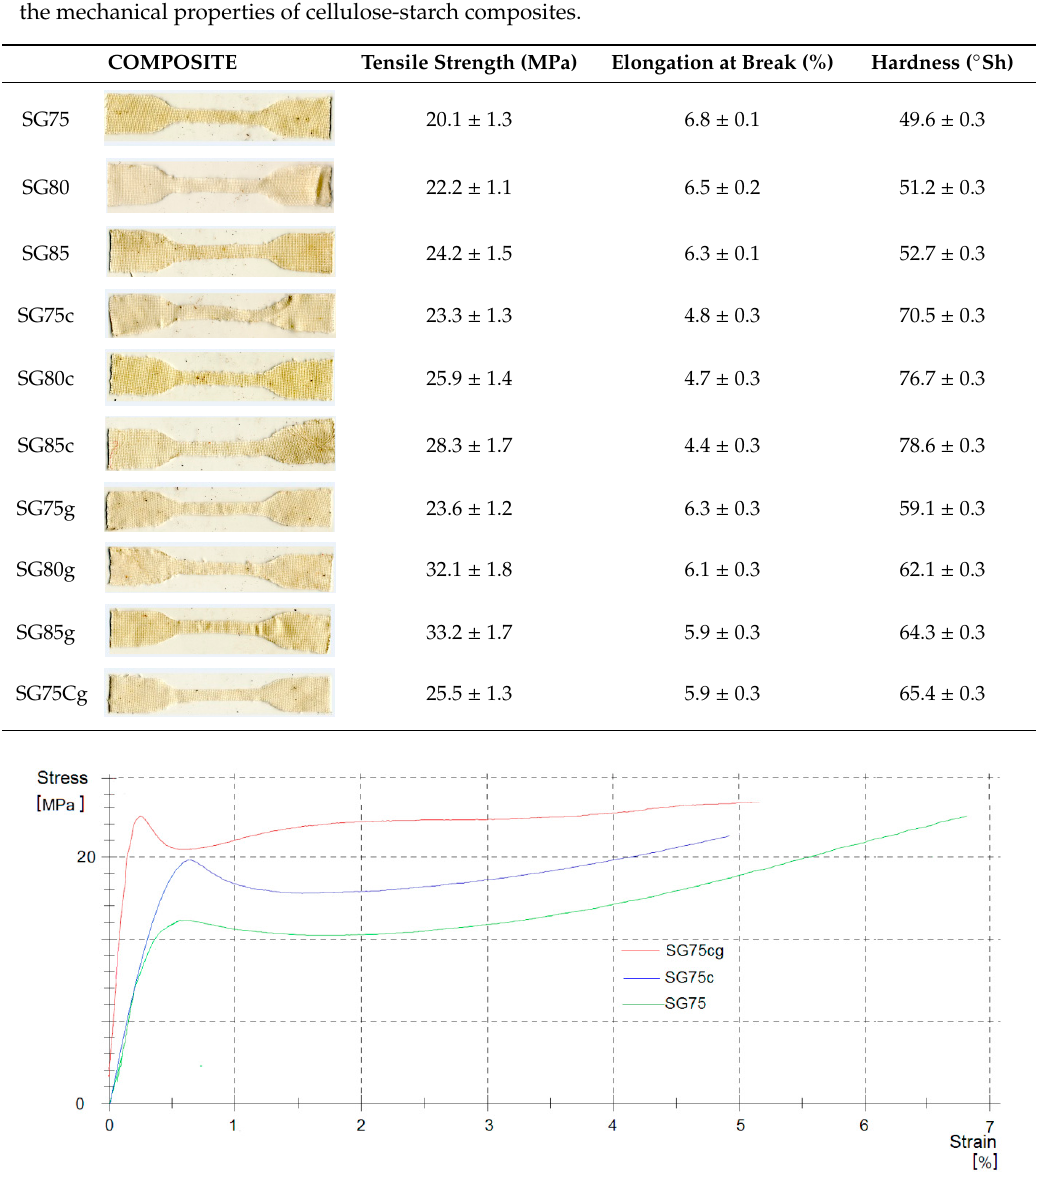
Figure 8. Representative strain curves from deformation (SG75, SG75c, SG75cg) in mechanical tests. As can be seen in Table 3, reducing the glycerin content improved the hardness of the composites considerably, while they also showed less flexibility. This is because glycerin acts as a plasticizer. Glycerin was added in different percentage shares, i.e., 25% (SG75), 20% (SG80) and 15% (SG85). The smaller the proportion of glycerin in the composites, the greater was their hardness in degrees Shore (°Sh) and the lower was their flexibility. A decrease in hardness of up to 12% was observed for casein composites (SG75c) with a reduced percentage of glycerin. This was due to the different chemical structures of the modifiers.